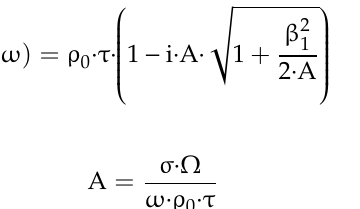
Figure S1: Impulse responses at individual microphone positions M1–M9 for standardised EN 1793-5 measurement of sound reflection index RI in configuration